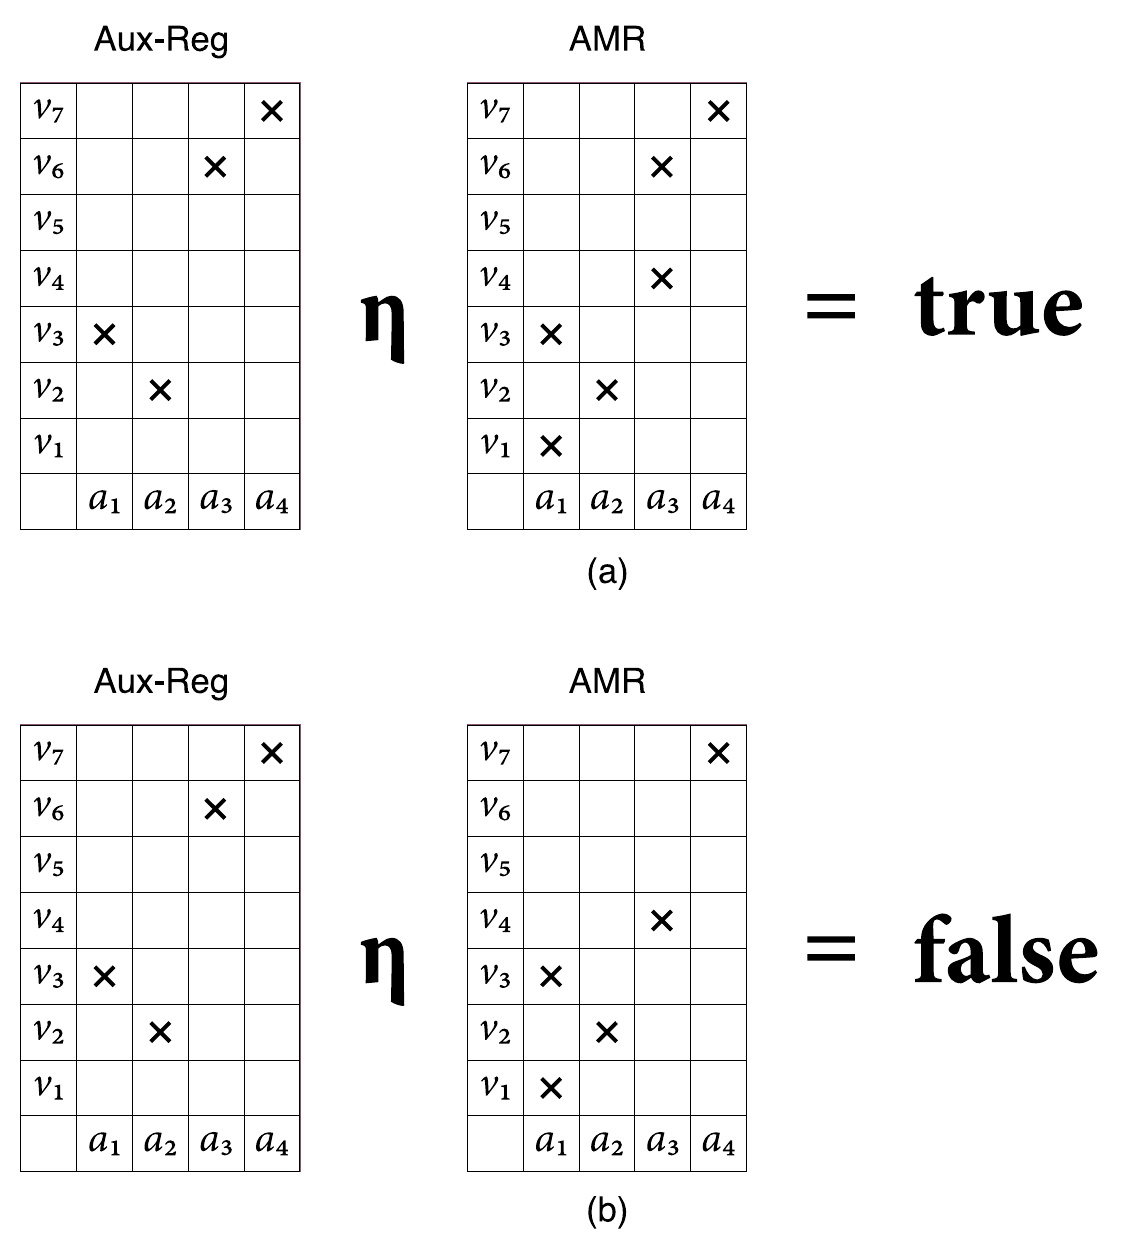
Fig 2. Memory recognition